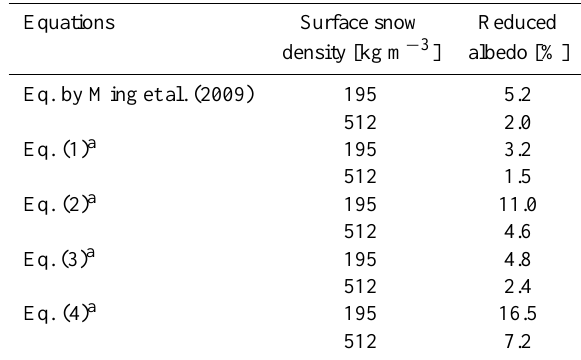
Table 4. Possible albedo reductions by different equations on the relationship between BC concentration and reduced albedo.